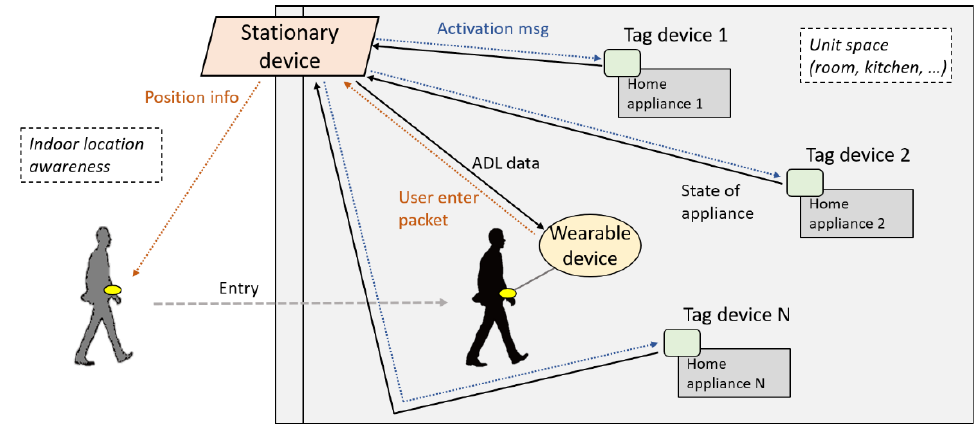
Figure 1. Concept of self-organized device network structure.